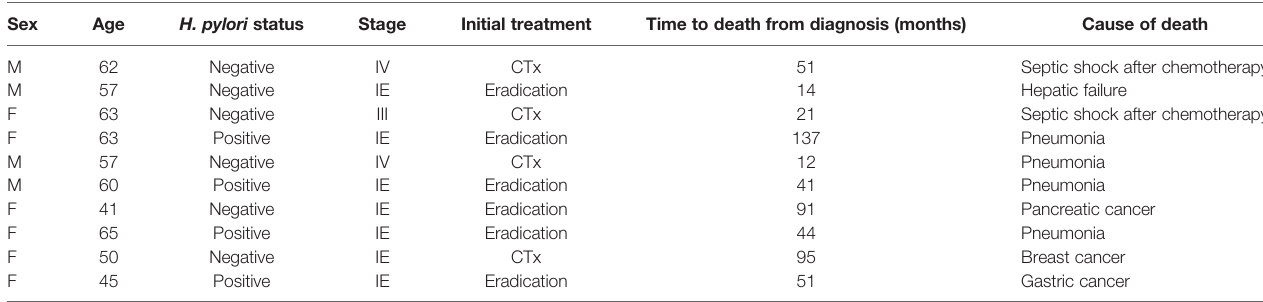
TABLE 3 | Summary of patients who died after gastric MALT lymphoma